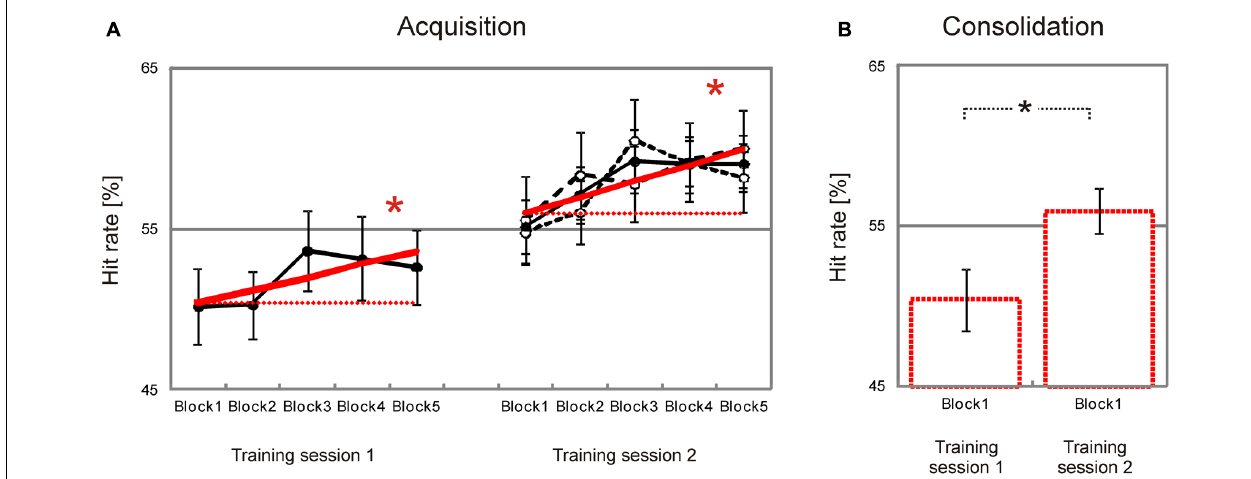
did not differ between participants who had a two-day interval between the two training sessions (open circles and narrow dashed black line in (A) , only shown for the second training session) and participants who had a longer interval between the two training sessions (open circles and wide dashed line in (A) , only shown for the second training session). Numbers on the y-axis indicate percentage of correctly recognized facial expressions (note that chance level is 25 percent). Error bars indicate SEM. Asterisks indicate significant effects ( p < 0.05).